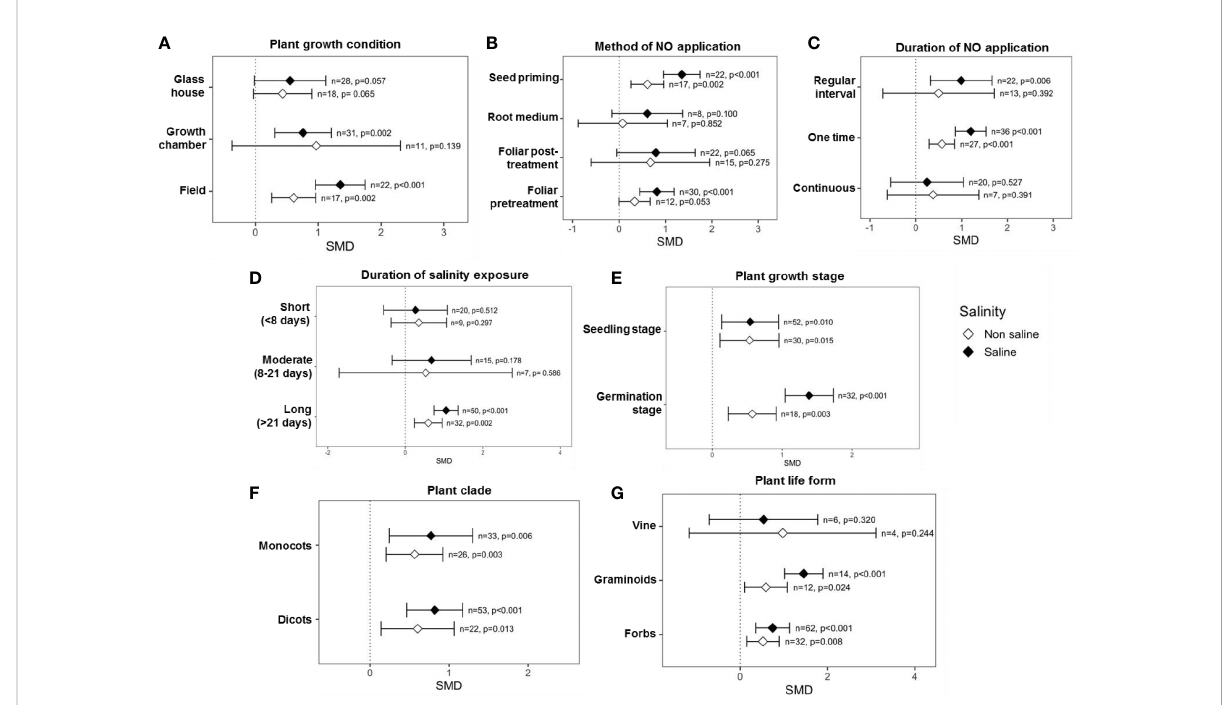
FIGURE 4 Effects of exogenous NO on SDW under saline and non-saline conditions for various categorical variables such as (A) growth conditions, (B) method of NO application, (C) duration of NO application, (D) duration of salinity, (E) plant growth stages, (F) plant clade, and (G) plant life form. The error bars are the effect size means ±95% CIs. Where the CIs do not overlap the vertical dashed lines, the effect size for a parameter is signi fi cant, i.e., the growth responses of NO-treated plants were signi fi cantly different from those of non-NO-treated plants. n , the number of studies included in the meta-analysis; p , the signi fi cance level of